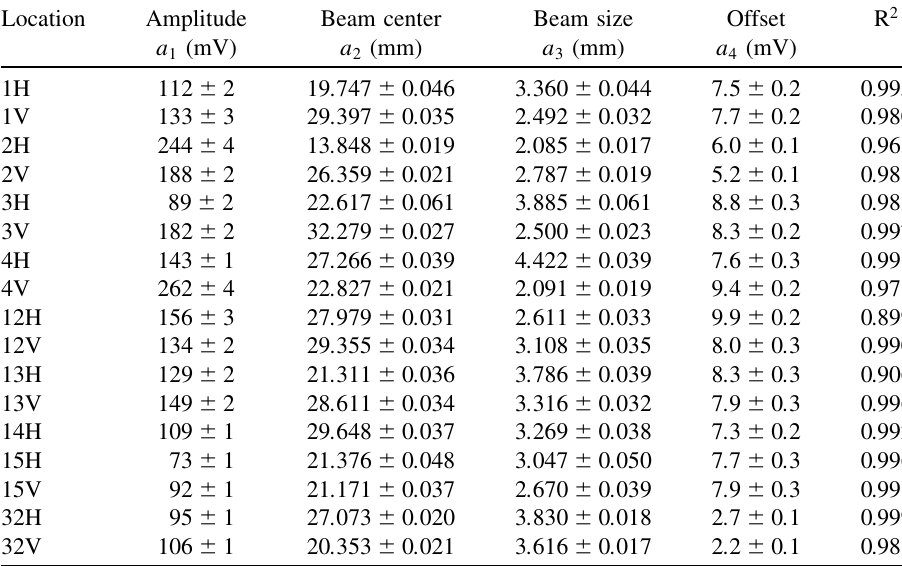
TABLE II. Measured beam parameters and fitting performance with Gaussian function. R 2 is the square of the correlation coefficient between measured and modeled values.